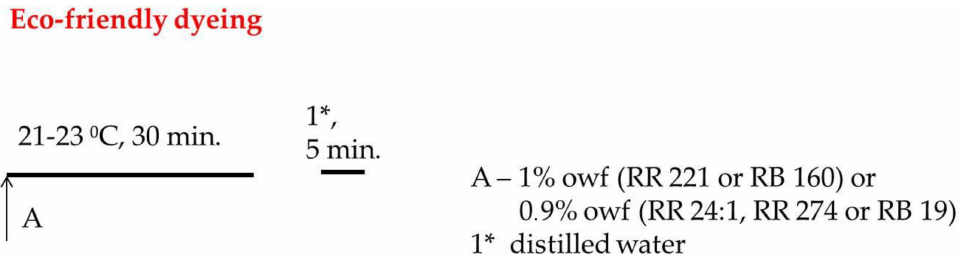
Figure 4. Diagram of dyeing process of cellulose cationised with [IME] + Cl −